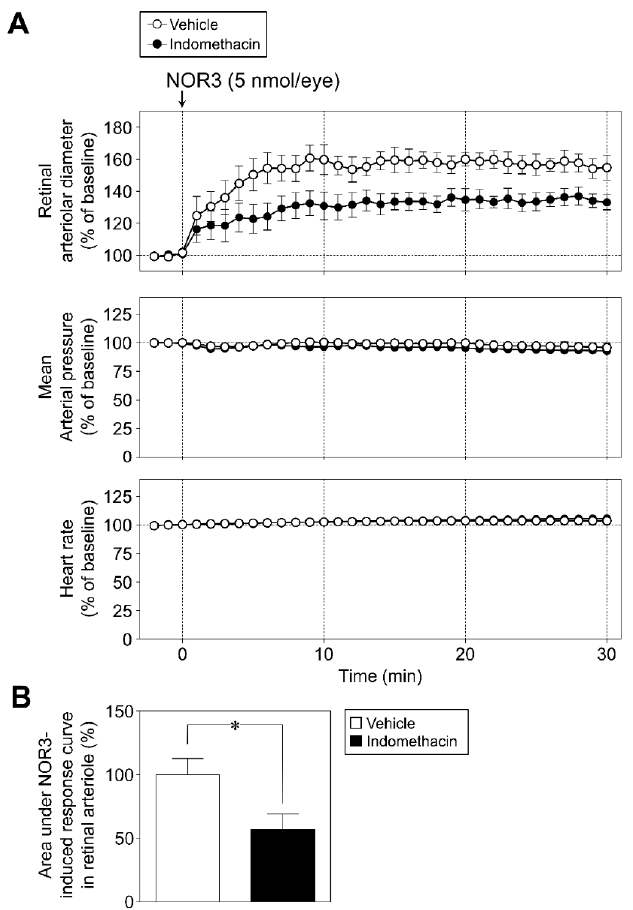
Figure 1. Involvement of prostaglandins in intravitreal injection of NOR3-induced retinal